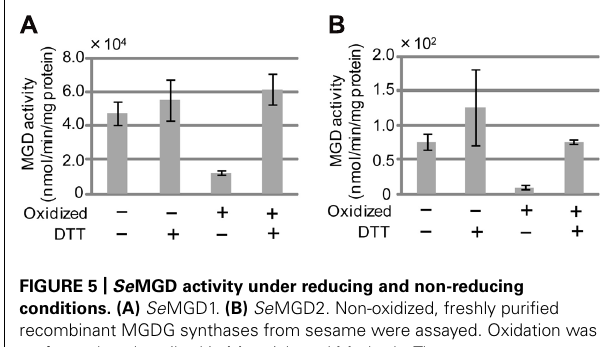
FIGURE 5 | Se MGD activity under reducing and non-reducing conditions. (A) Se MGD1. (B) Se MGD2. Non-oxidized, freshly purified recombinant MGDG synthases from sesame were assayed. Oxidation was performed as described in Materials and Methods.The assay was performed in the presence ( + ) or absence ( − ) of dithiothreitol (DTT).Values represent the mean ± SD from three independent